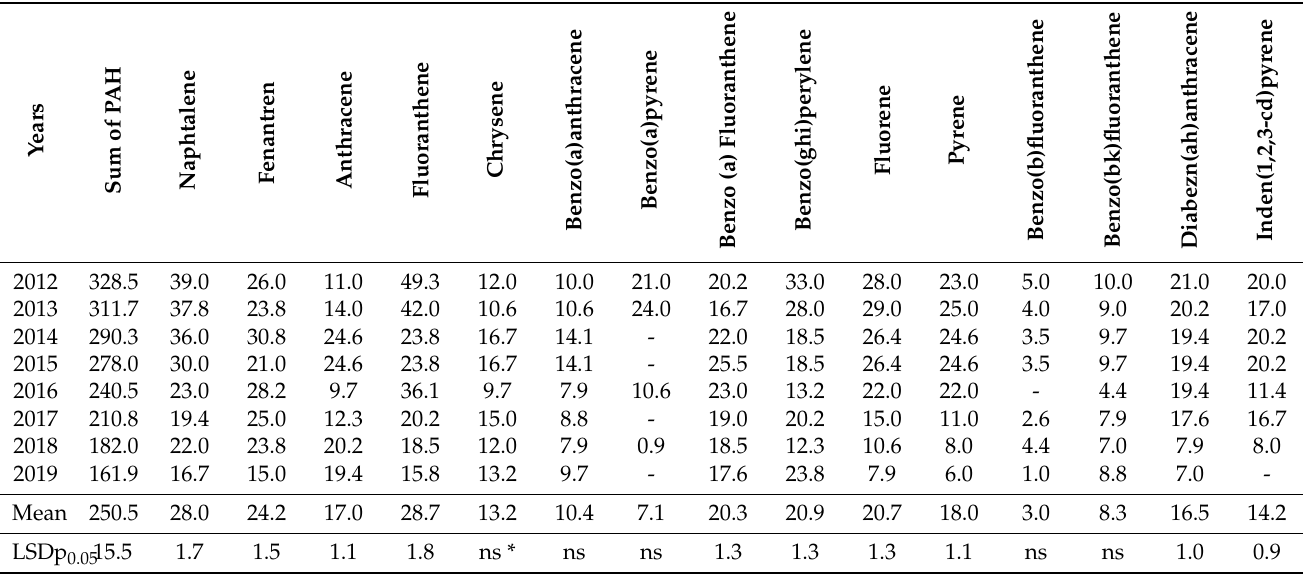
Table 5. PAH content in the soil of the field trials between the years 2012 and 2019 (expressed in µ g kg − 1